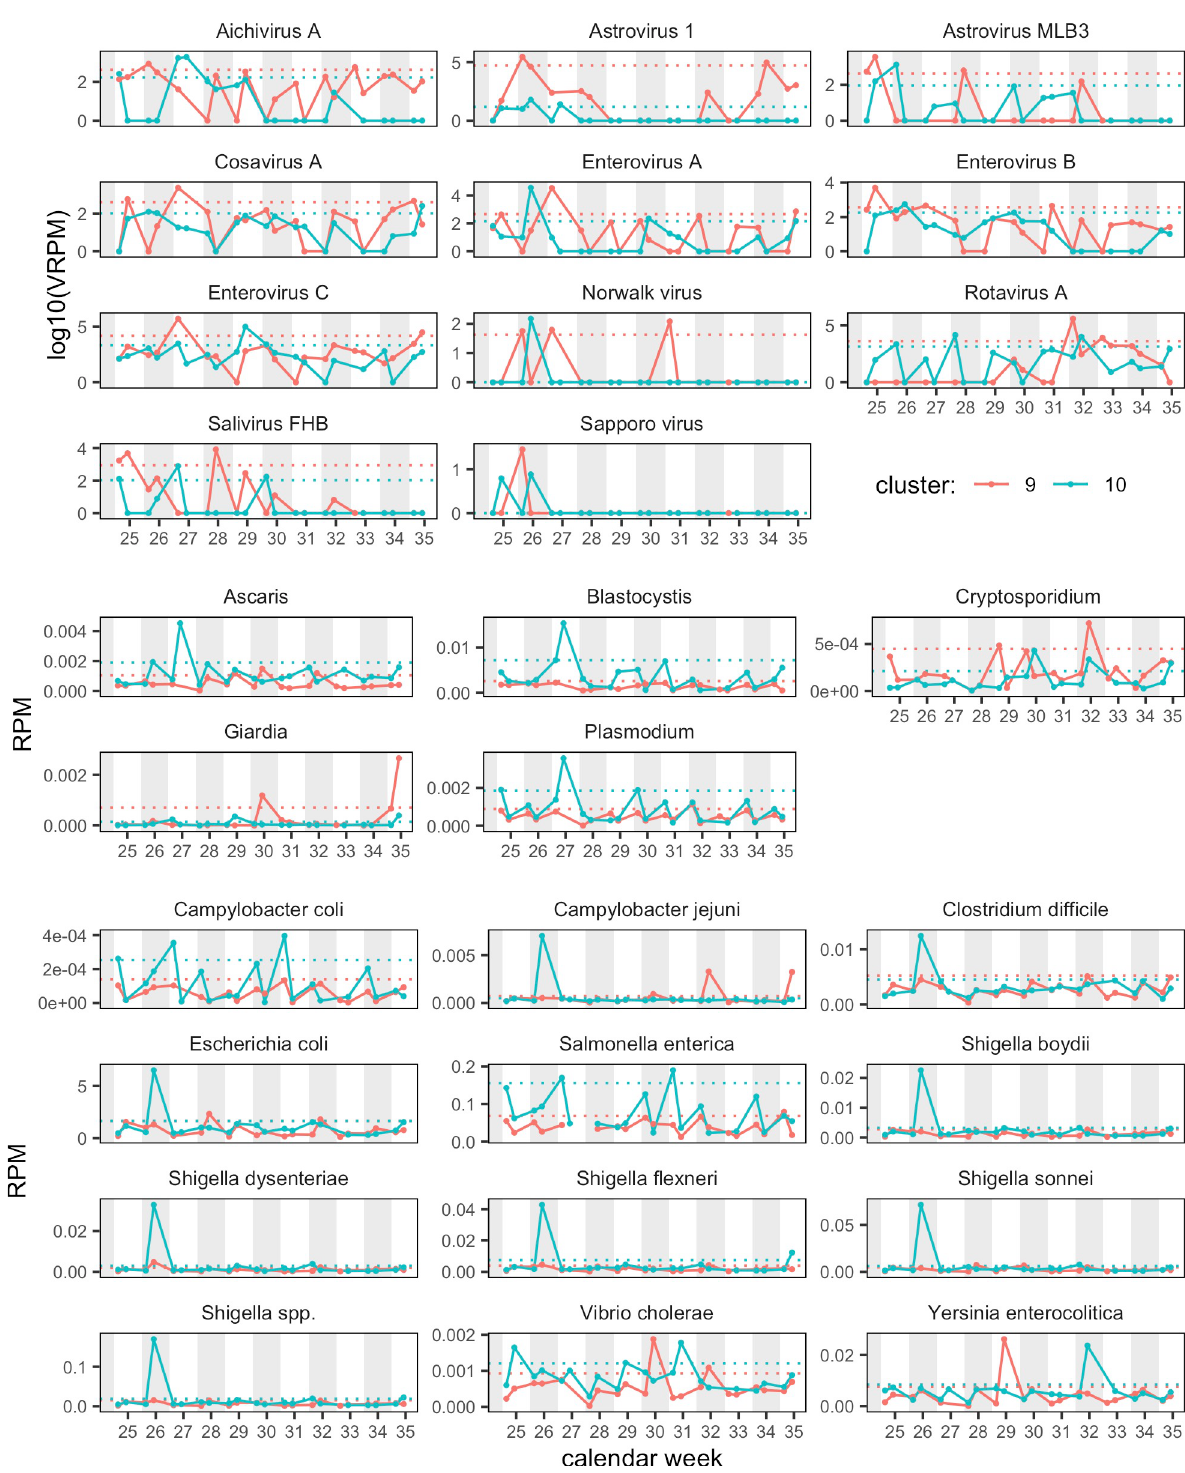
Fig 3. Relative read abundance (in RPM: Reads per million) of 27 human pathogens, (10 viral, 5 parasites, 12 bacterial) in sewage from Kibera. Red: cluster 9; blue: cluster 10. The dotted horizontal lines show upper limits for each cluster. Note that viral data are shown on the logarithmic scale (log10). Note that scale is individual for each